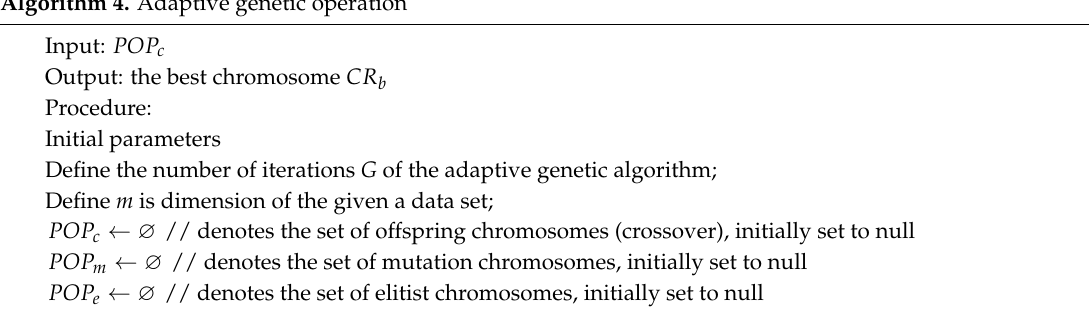
Algorithm 4. Adaptive genetic